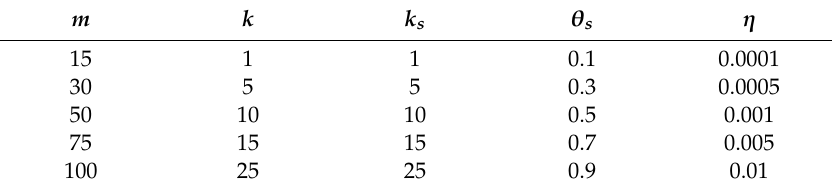
Table 7. Factors and levels for F2 and F3.